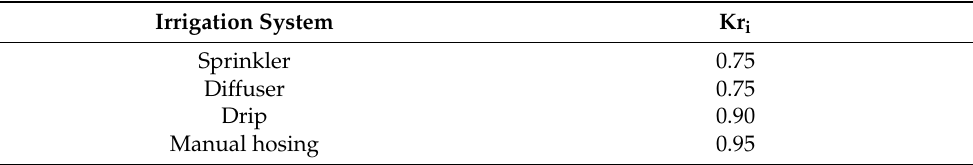
Table 7. Examples of efficiencies (Kr i ) for different irrigation systems.